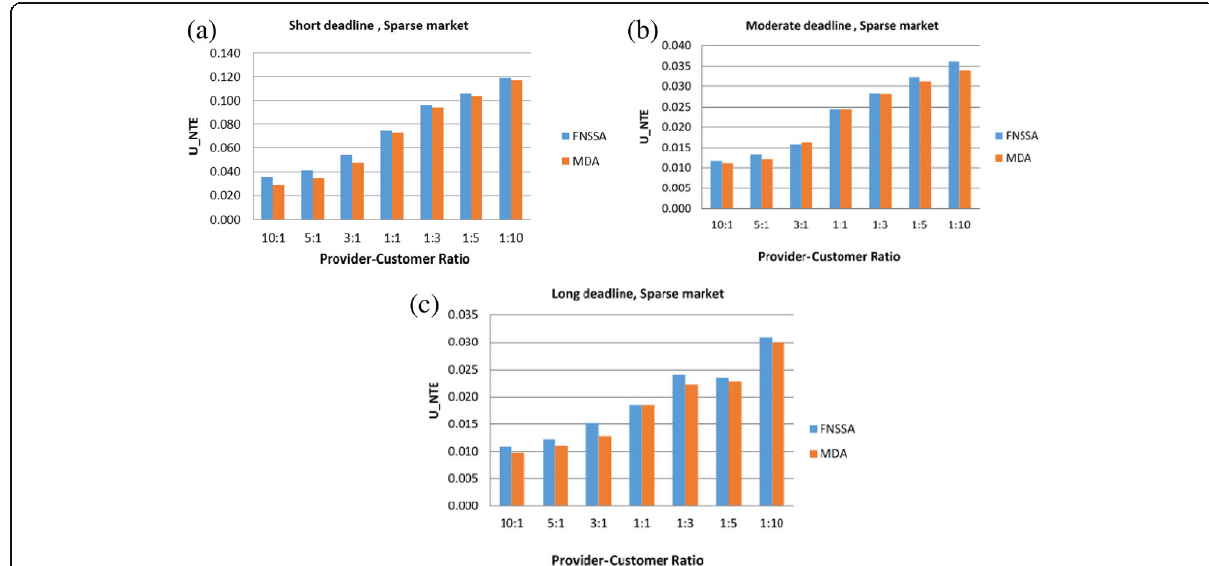
Fig. 11 The U_NTE of the CRPAs under a short deadline and sparse market, b moderate deadline and sparse market, and c long deadline and sparse market. In all figures different market types are considered